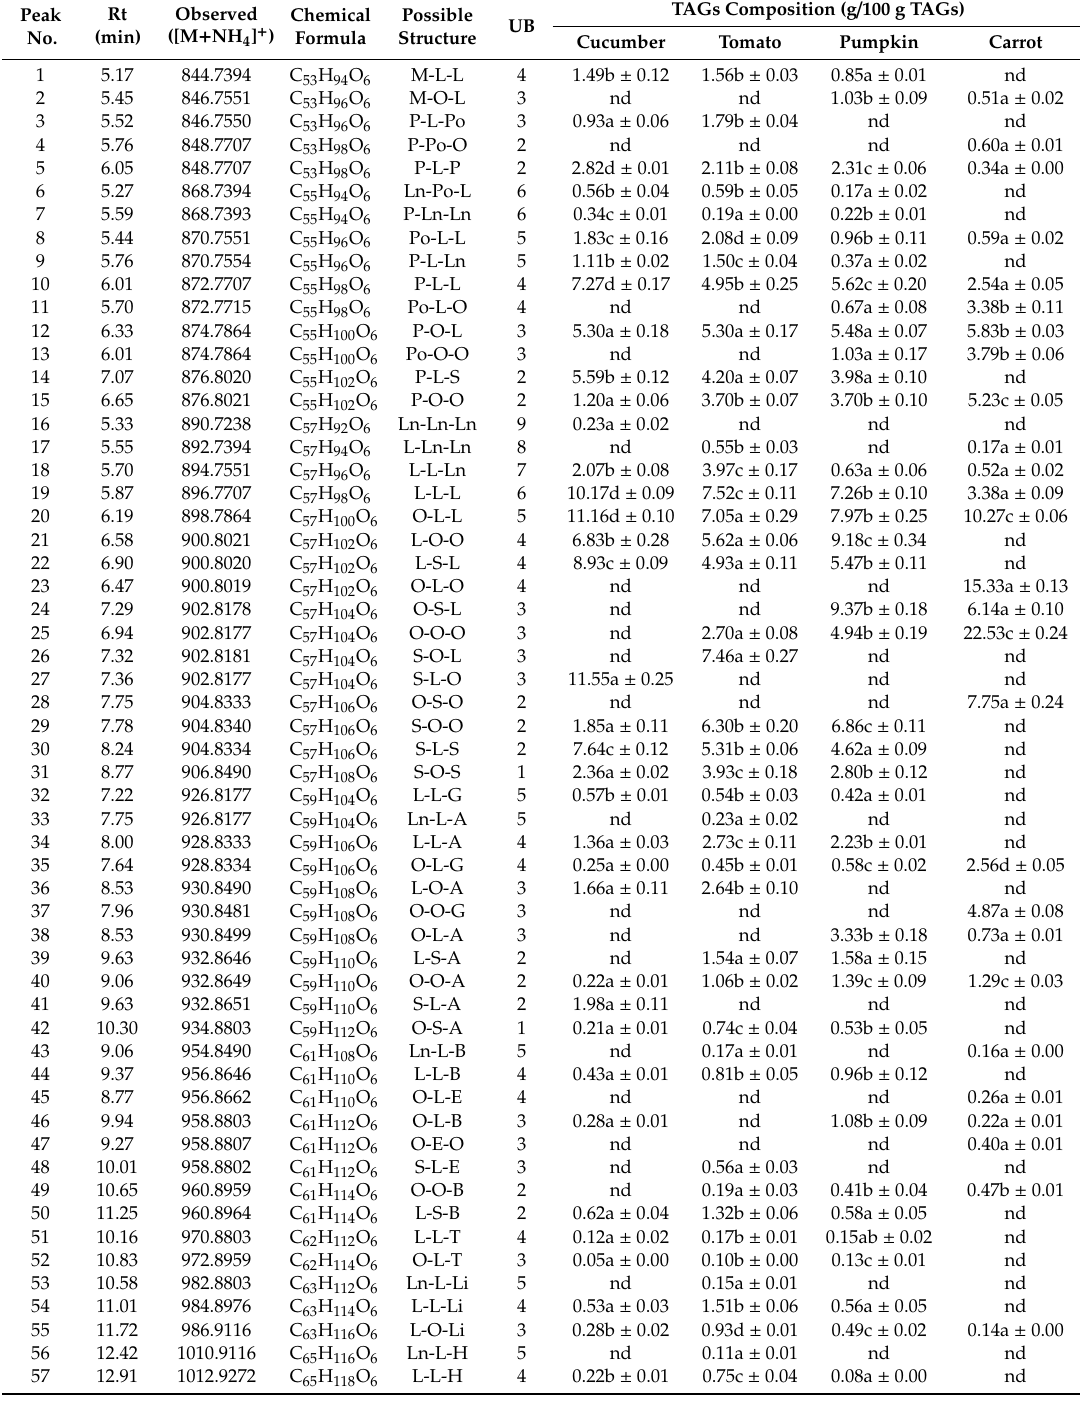
Table 1. Identification and relative concentration of triacylglycerols in cucumber, pumpkin, carrot, and tomato seed